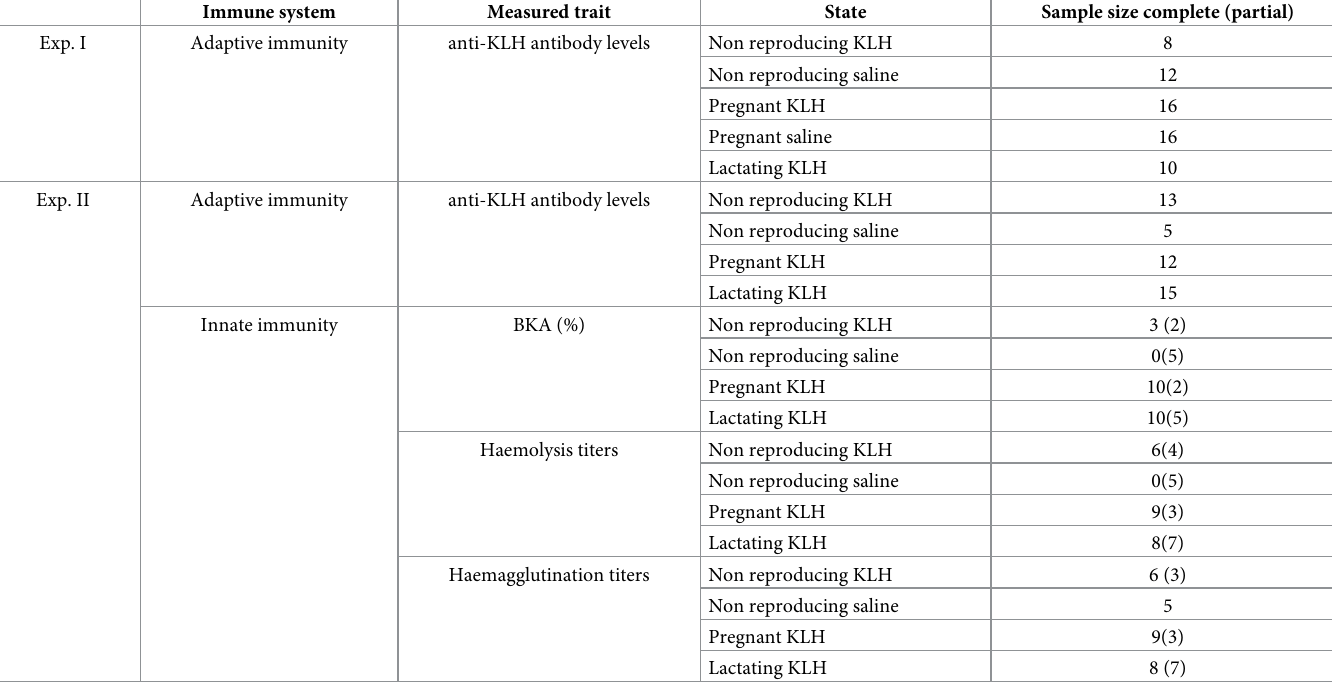
Table 1. Sample size for analyses of adaptive and innate immunity. Numbers in brackets indicate the number of animals for which samples were missing at different points in time. KLH: Injected with an isotonic solution of KLH. Saline: Injected with an isotonic saline solution. Immune system Measured trait Exp. I